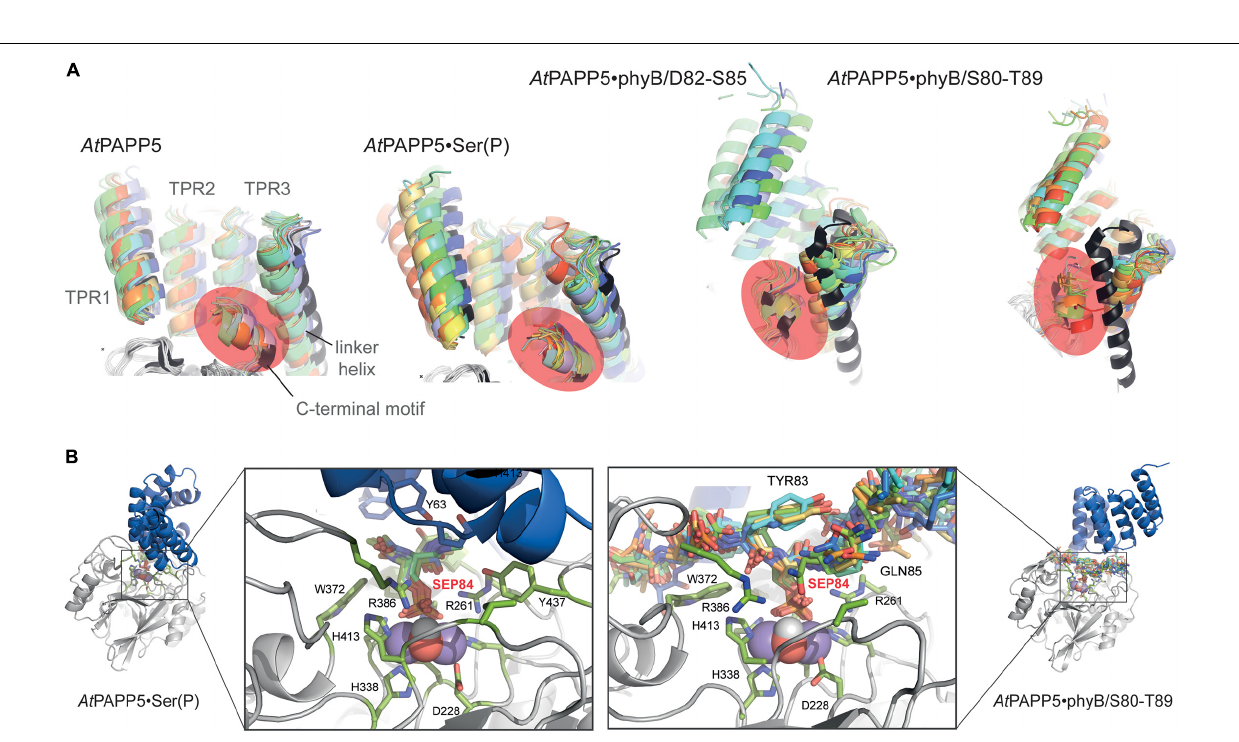
Frontiers in Plant Science |